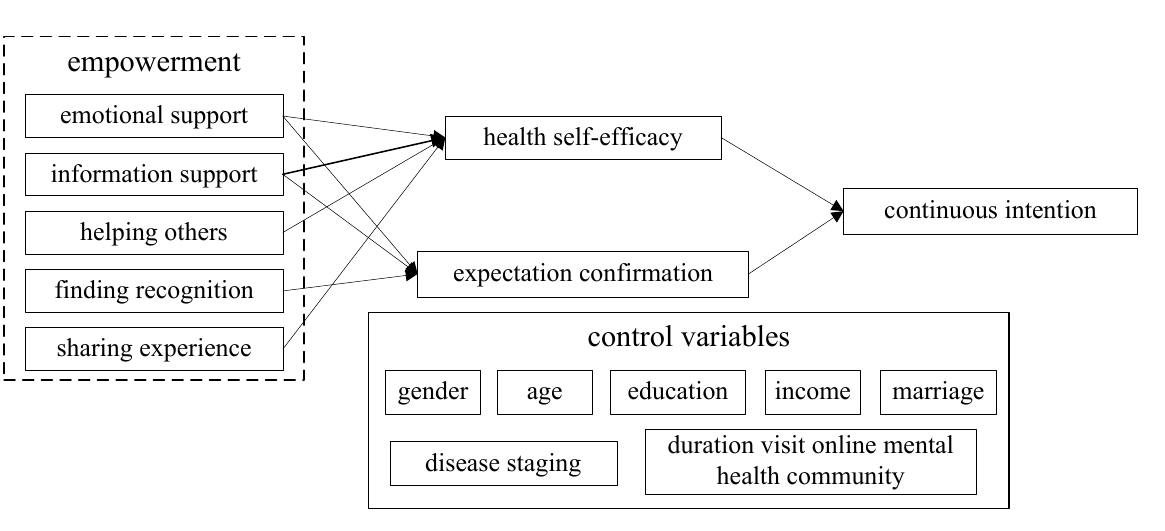
Figure 1. Research model.